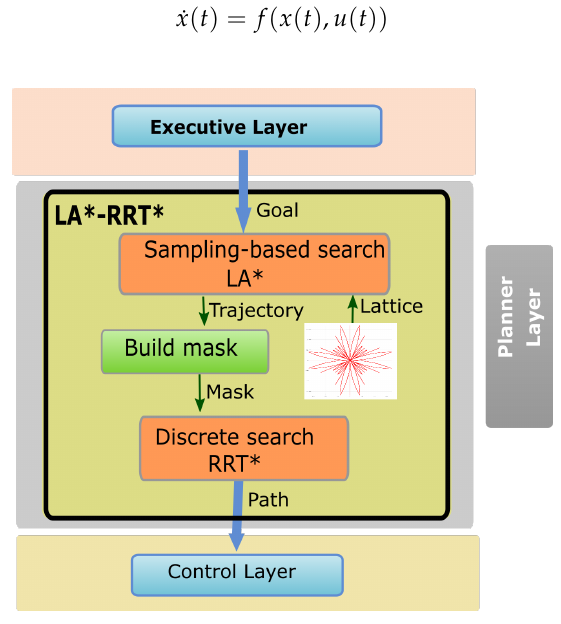
Figure 3. LA*-RRT* block